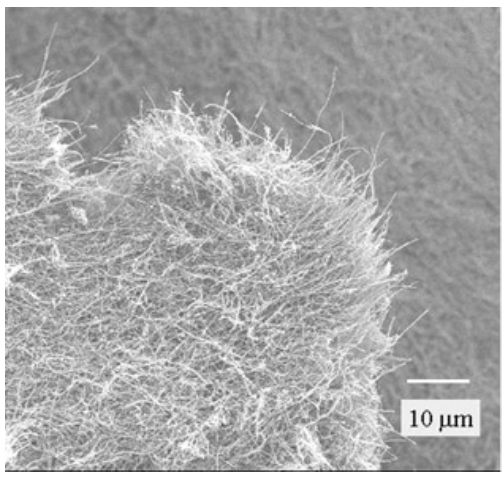
Figure 3. SEM picture of the residues from a burned CNT/PP nanocomposite. Reprinted from